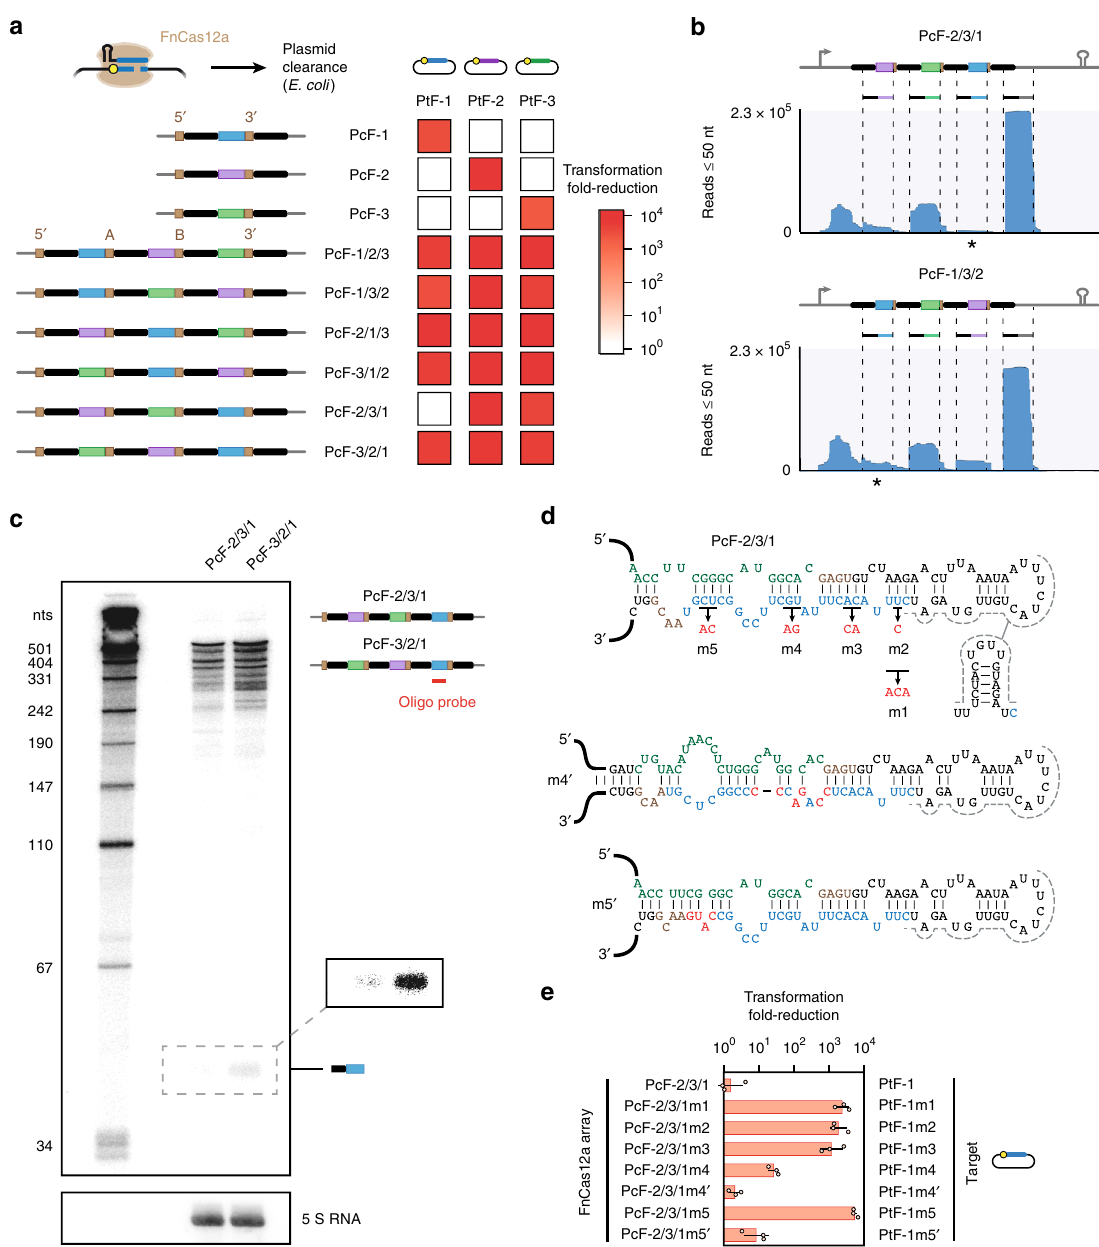
Fig. 6 Loss of plasmid clearance linked to low crRNA abundance and global RNA secondary structure. a Multiplexed plasmid clearance by FnCas12a in E. coli . See Fig. 3a for details. Sequences of the spacers and junctions in the assembled arrays are shown in Supplementary Table 4. b RNA-seq analysis of the three-spacer arrays in PcF-2/3/1 and PcF-1/3/2. Each array and FnCas12a were co-expressed in TXTL prior to small-RNA isolation and RNA-seq analysis. See Fig. 5 for details. Stars indicate mapped reads for spacer S1. c Northern blotting analysis of the transcribed arrays from PcF-2/3/1 and PcF-3/2/1. Each array and FnCas12a were co-expressed in E. coli prior to total RNA isolation and Northern blotting analysis. The region in which the processed crRNAs should appear is shown with greater intensity. The analysis was conducted with a radiolabeled oligo probe complementary to spacer S1. Detection of 5S RNA was used as a loading control. Gel images from an independent experiment are in Supplementary Fig. 7. d Mutations made within a predicted imperfect hairpin between spacers S1 and S3. The predicted hairpin was present as a stable structure (base-pairing probabilities > 80%) only in PcF-2/3/1. Note that the structure prevents formation of the hairpin recognized by FnCas12a (gray dashed line). One set of mutations (m1 – m5) were selected to disrupt the predicted secondary structure. Another set (m4 ’ , m5 ’ ) represents expanded mutations to m4 and m5 that reform a stable secondary structure. Predictions of the minimal-free energy structure and base-pairing probabilities were made for the sequence spanning the 5 ′ repeat through the 3 ′ spacer. Text is colored to match that of spacer S3 (green), spacer S1 (blue), the assembly junctions (brown), and the intervening repeat (black). Mutations are in red. e Plasmid clearance directed by FnCas12a and the mutated versions of PcF-2/3/1. The protospacer in the target plasmid was mutated to match each changed spacer sequence. See Fig. 3a for details. Sequences of the spacers and junctions in the assembled arrays are shown in Supplementary Table 4. Values represent the geometric mean and S.D. from three independent transformations starting from separate colonies. Source data are provided as a Source Data fi